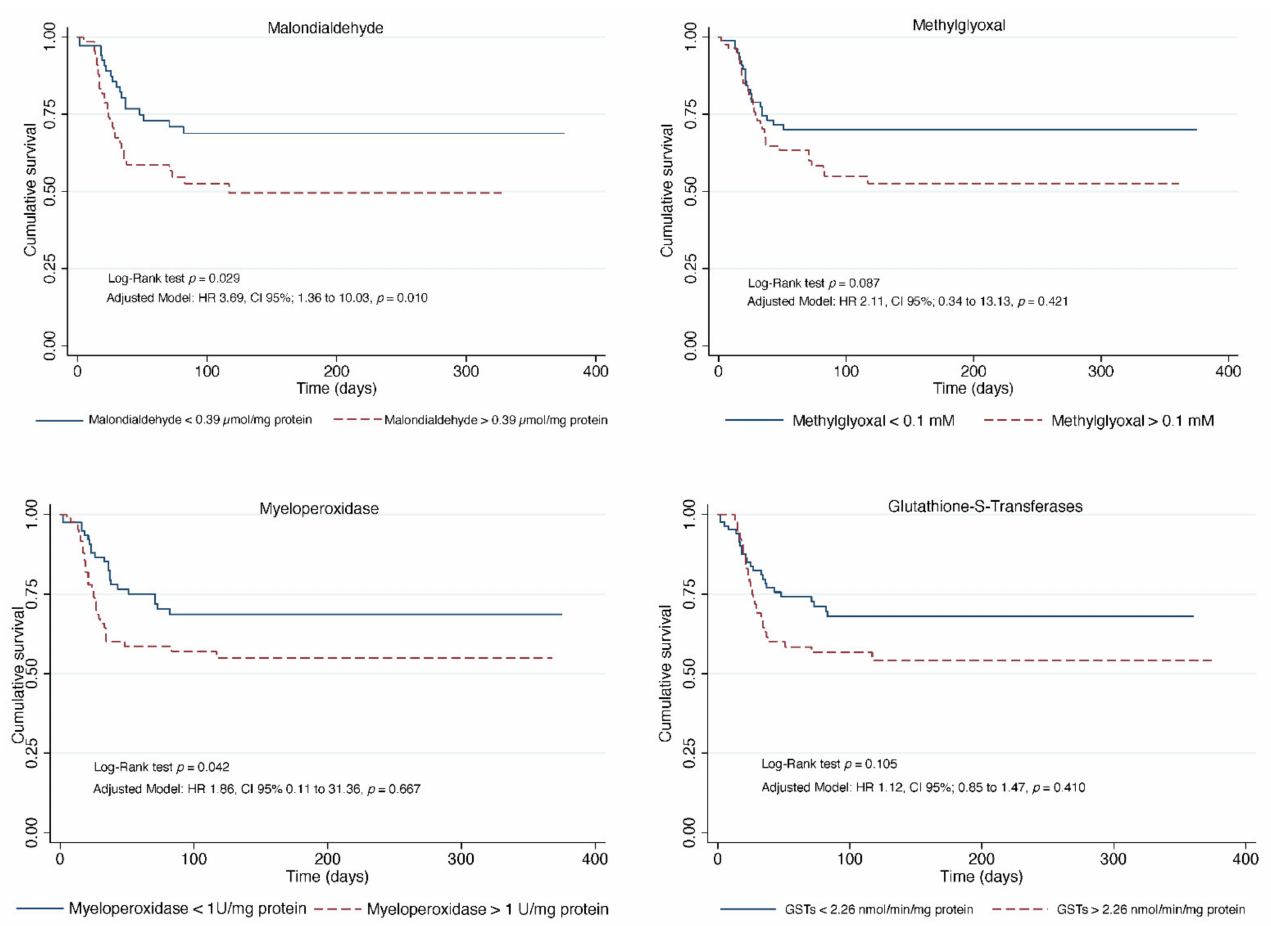
Figure 4. Kaplan-Meier curves for oxidative stress